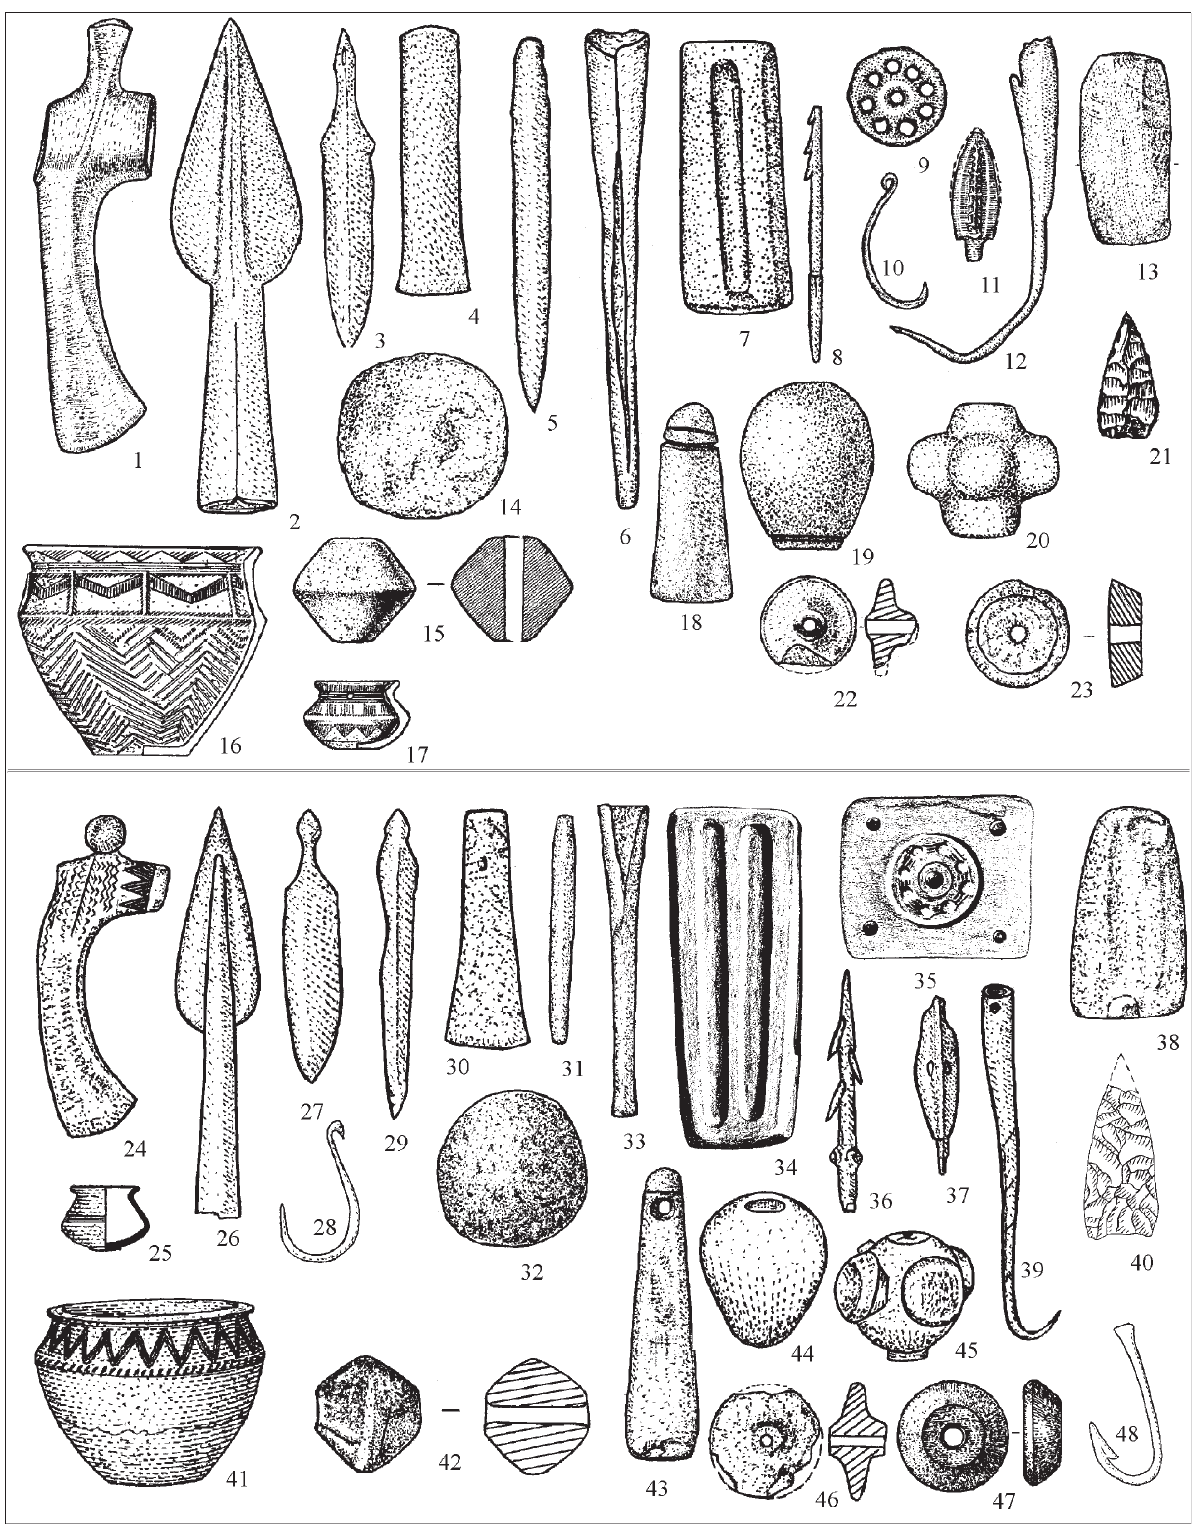
Figure 15: Objects of Sintashta culture (1–23) and their analogues in the Middle East and the Caucasus (24–48): 1, 3, 4, 10, 11, 13, 14–19, 21–23 – Sintashta; 2, 20 – Kamenniy Ambar V; 5, 6 – Tyubyak; 7–9, 12 – Arkaim; 8 – Bolshekaragansky; 24 – Kumbulta; 25 – Tell Mardikh; 26 – Esheri; 27 – Ur; 28, 45, 48 – Susa; 29, 30 – Gaza; 31 – Calicaköyü; 32, 38, 42, 43 – Demircihöyük; 33, 37 – Alaca Höyük; 34 – Malatya- Arslantepe; 35 – Kültepe (Karum); 36 – Tell ed-Dab’a; 39 – Kirovokan; 41, 46 – Hama; 44 – Nahal Mishmar; 47 – Arich (after Grigoriev,